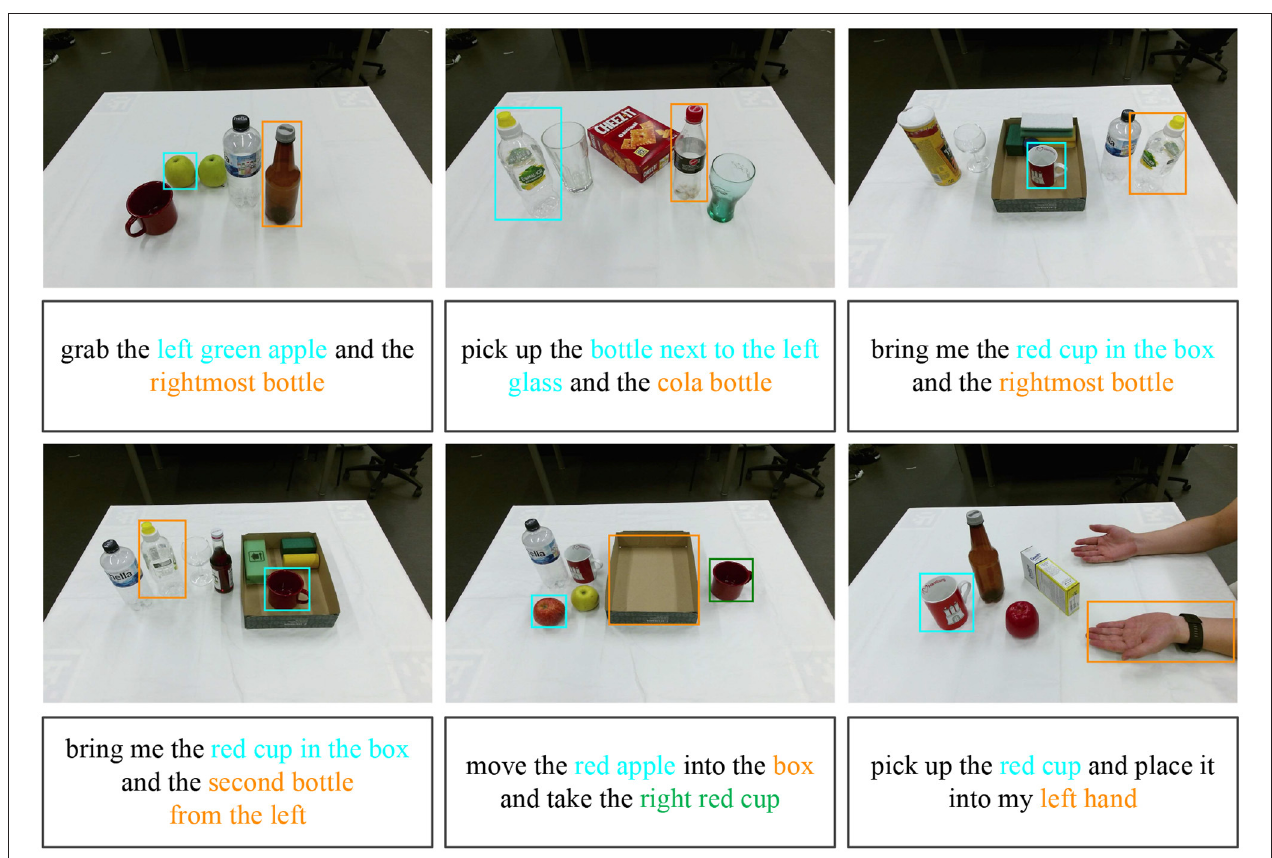
FIGURE 6 | Example results of interactive natural language grounding on self-collected scenarios. The input natural language are listed in the rectangles, and the parsed scene graph legends are covered with related colors.